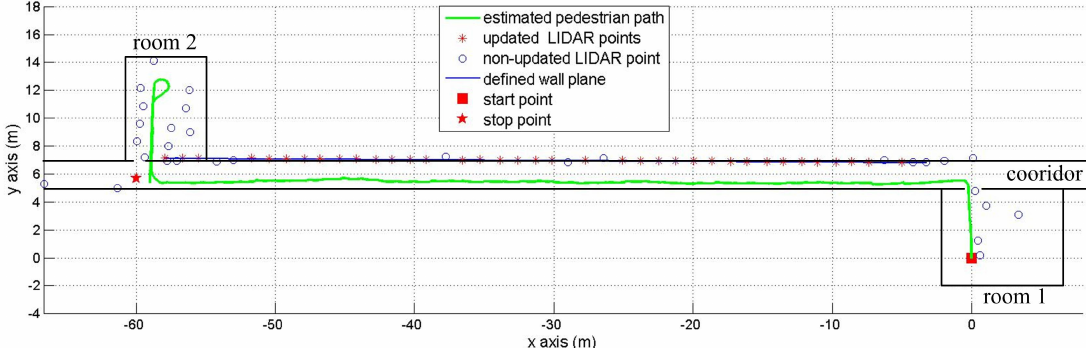
Figure 12. Pedestrian with complex path.